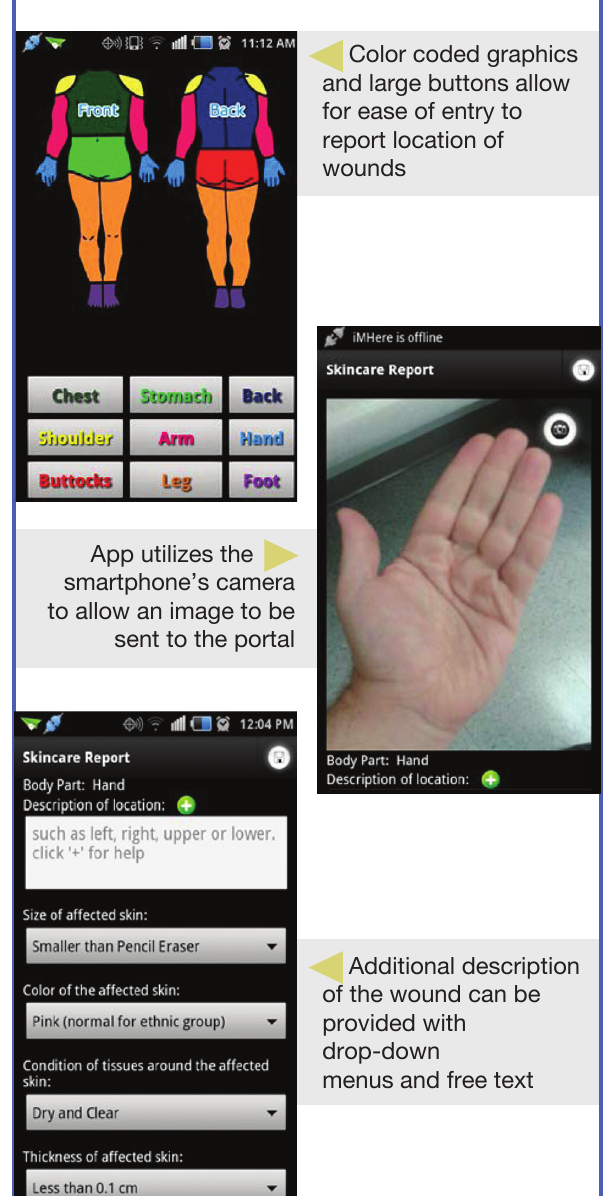
Figure 7: The Skin Care App has several screens to allow user to report wounds Color coded